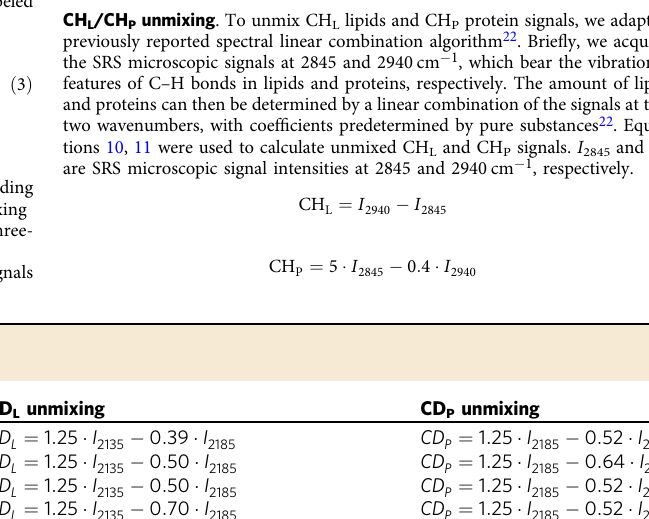
CD L unmixing CD P unmixing